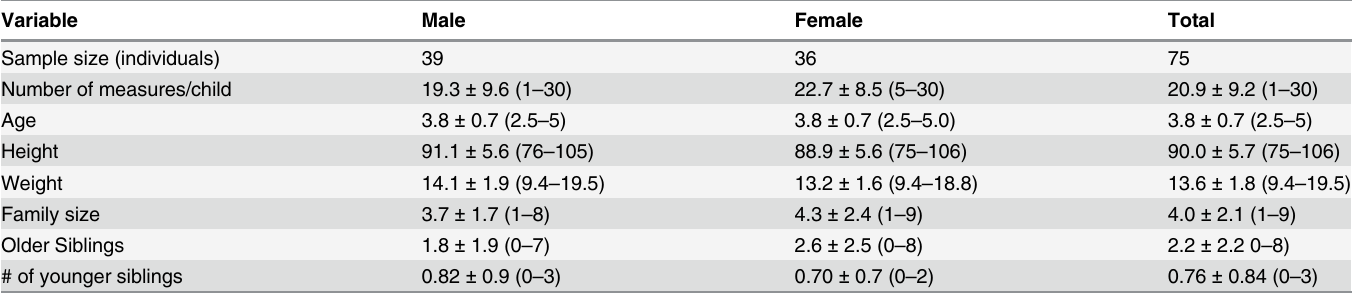
Table 1. Sample characteristics for Maya children ages 2.5 – 5.0, showing mean, standard deviation and range in parentheses. Age, height and weight are averaged across the 5-year sample. Family size, number of older siblings and number of younger siblings are averaged from each child ’ s last measurement.